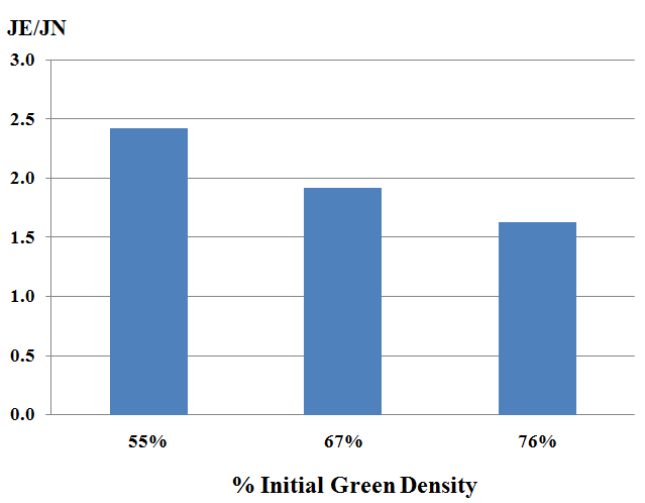
Figure 9. Initial effective current density/nominal current density ratio for different investigated green